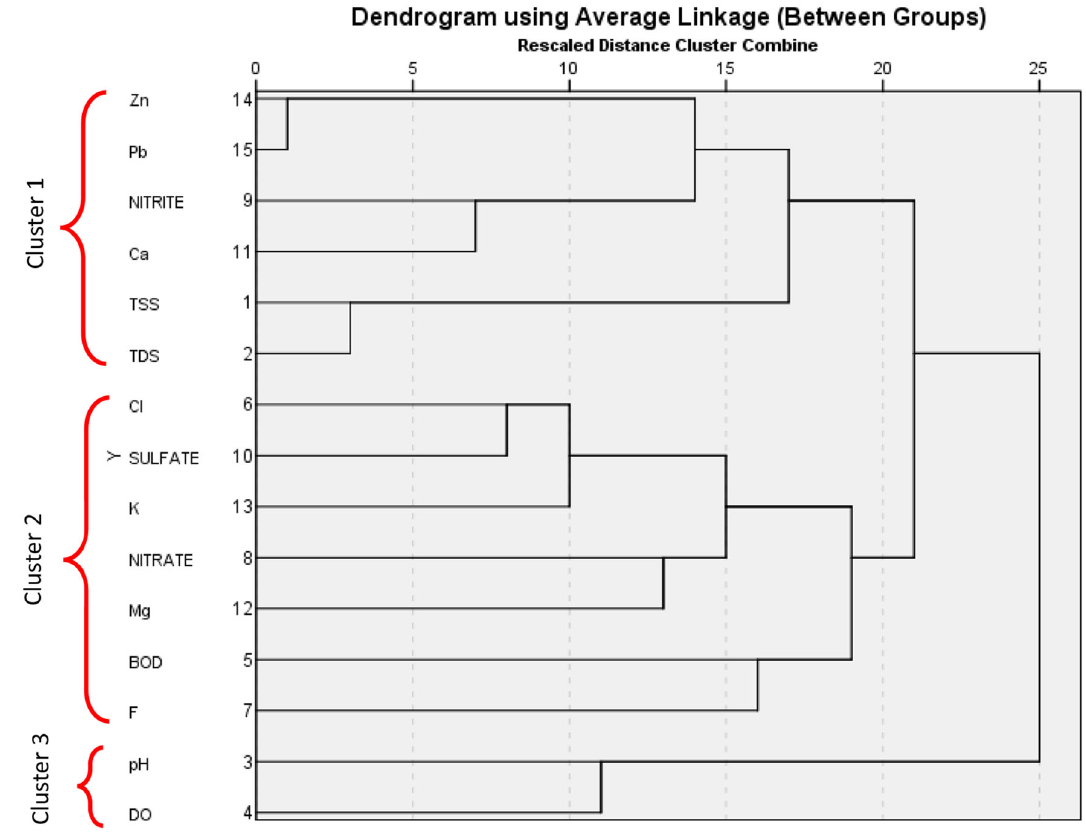
Fig. 11 Dendrogram showing the hierarchical clusters of analyzed